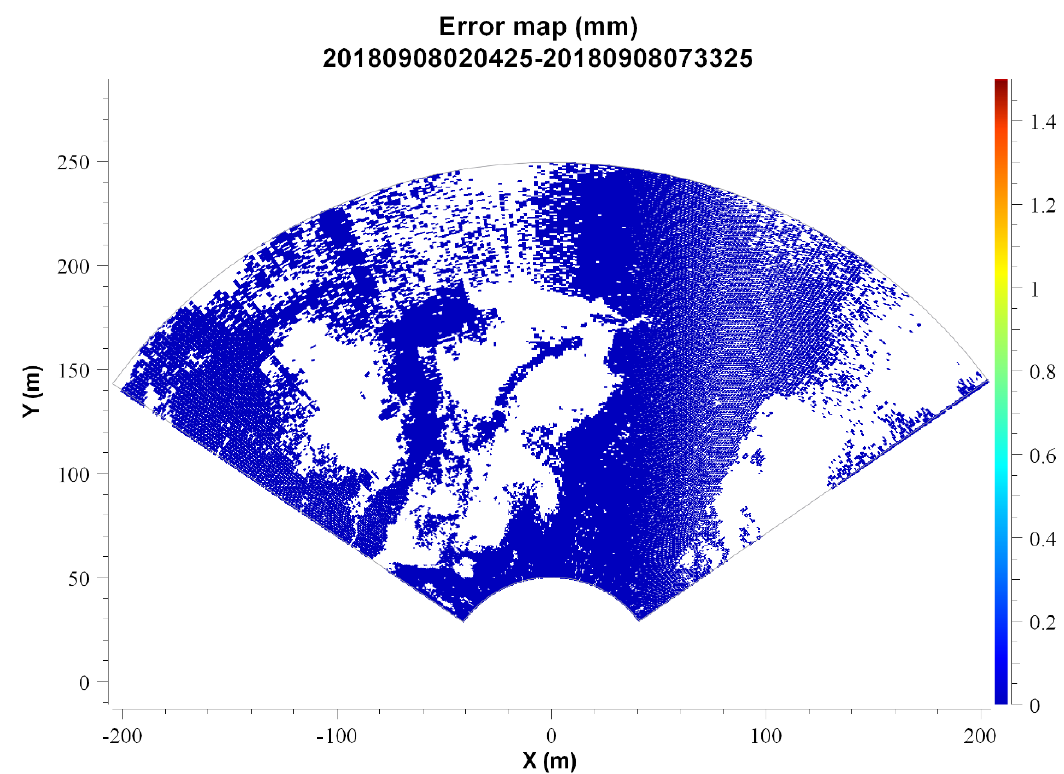
Figure 7. Unwrapping errors.